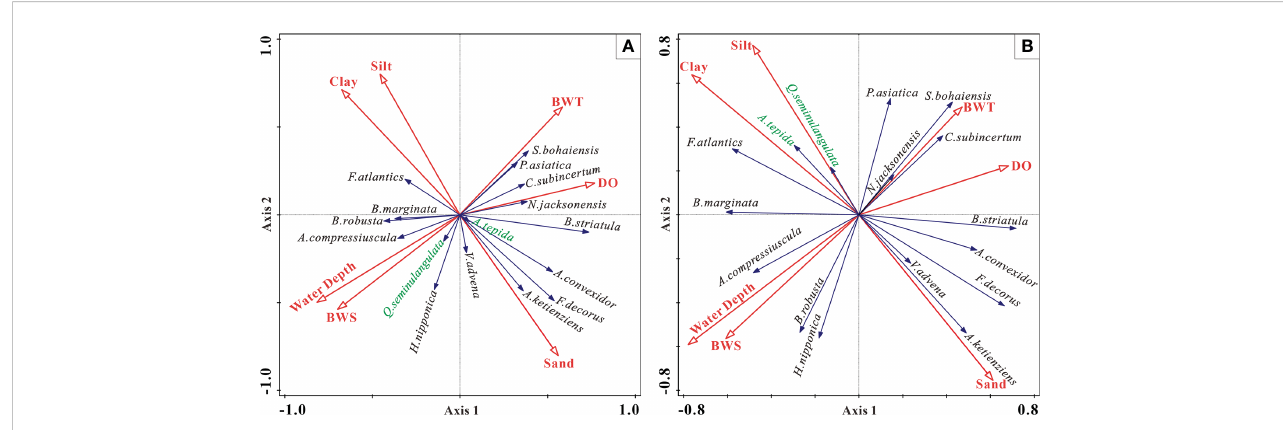
FIGURE 7 RDA ordination diagrams of living benthic foraminiferal fauna (A) and taphocoenose benthic foraminiferal fauna (B) with key environmental variables (BWS, BWT, DO and sediment size) measured in the summer of